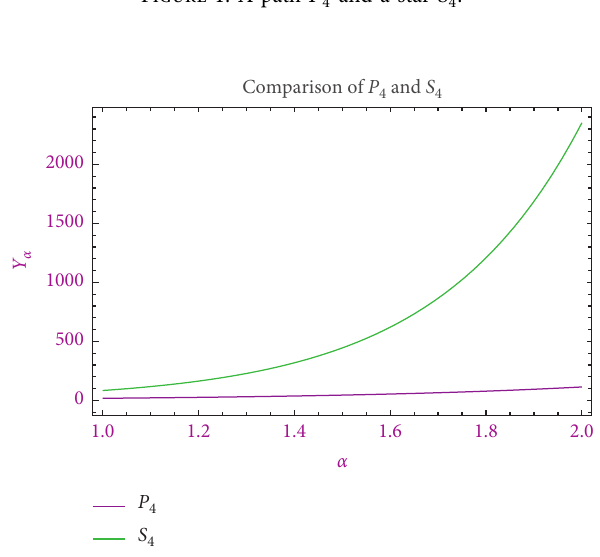
Figure 2: Plot for Y